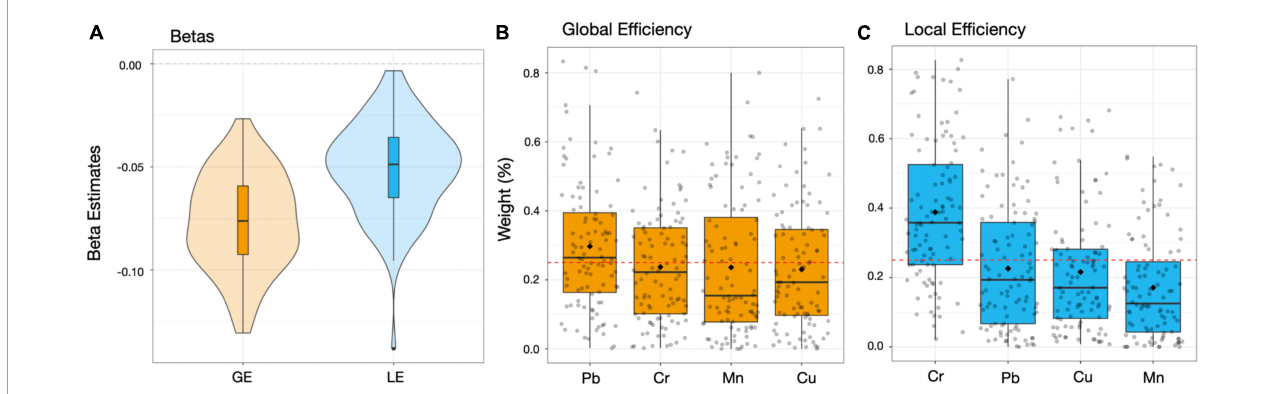
FIGURE3 Second level MMBs approach. Beta coefficients (A) and weights (B,C) obtained from the WQS association between each MMB metal and GE or LE was estimated among 193 adolescents included in the current study. Panel a reports the beta coefficients for GE (orange) and LE (blue), respectively. In panels (B,C) , data points indicate weights for each of the 100 holdouts; box plots show the 25, 50, and 75th percentiles while the whiskers show the 10 and 90th percentiles of weights for the 100 holdouts. Diamonds show the mean weights for the 100 holdouts. Dotted lines indicate the thresholds. Mn, manganese; Pb, lead; Cr, chromium; Cu,